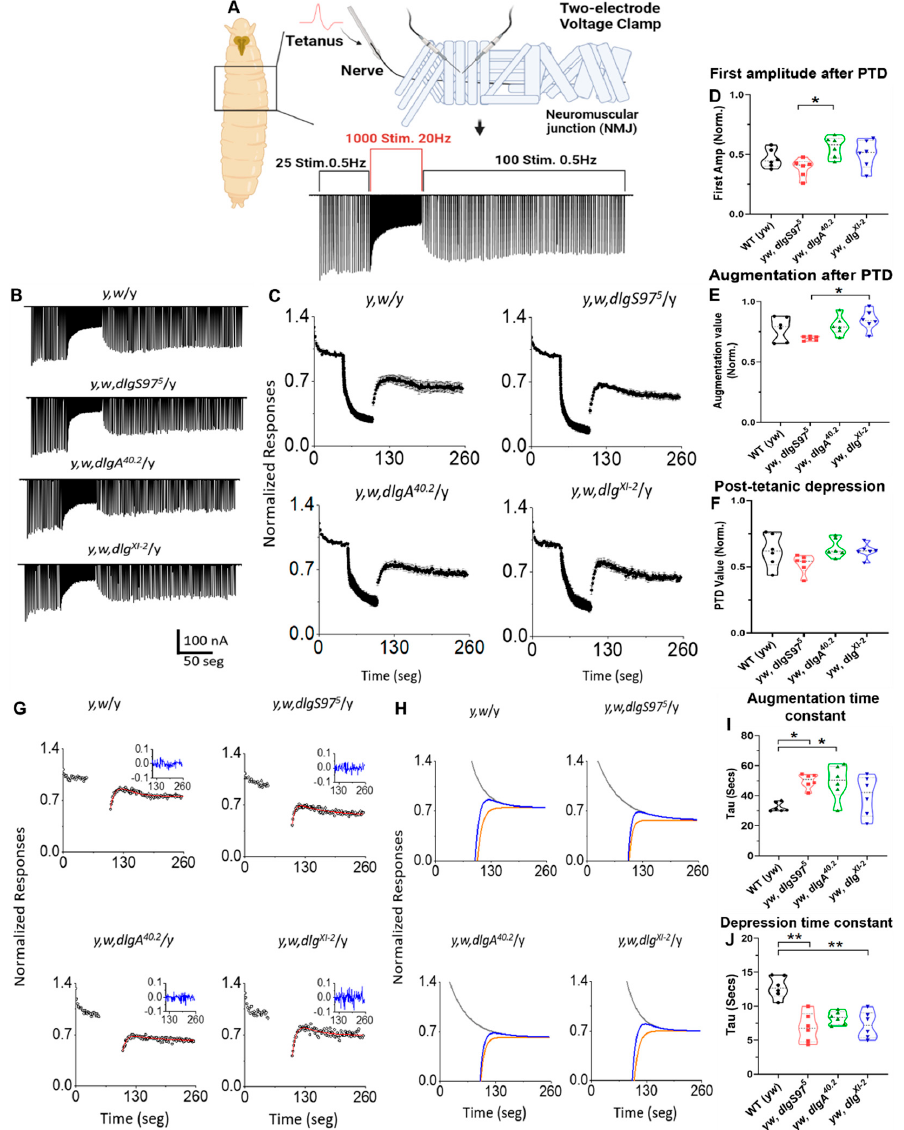
Figure 1. dlg mutants can sustain post-synaptic responses after HFS, alter augmentation, and depression time-course. ( A , B ) Nerve-evoked junctional currents in control and dlg mutants elicited during a paradigm of stimulation to induce post-tetanic potentiation (Created with BioRender.com). The conditioning episodes are the 50 s at 20 Hz and 0.5 Hz for test stimulation. The recordings were obtained at 2 mM of external Ca 2+ ; ( C ) Average responses normalized to the mean pre-tetanic value in the control and dlg mutants; ( D ) Average responses of the first normalized amplitude after the tetanic stimulation; ( E ) Augmentation of post-tetanic responses, corresponding to the maximum value reached after the conditioned tetanus; ( F ) Post-tetanic depression, corresponding to the average of the 10 last responses. Bars indicate the standard error, n = 6; ( G ) Normalized nerve evoked responses from representative recordings during the test stimulation at 0.5 Hz before and after the high frequency of nerve stimulation episodes in control and dlg mutants. The inset shows the residual plot of the fitted model to the data, the line in red is the fitted curve; ( H ) Individual post-tetanic augmentation (grey) and depression (orange) with convolved function (blue) in each genotype; ( I ) The time constant for augmentation (Kruskal–Wallis, Dunn test * p < 0.05); ( J ) The time constant for depression (Kruskal–Wallis, Dunn test ** p < 0.01). Bars indicate the standard error, n = 6.